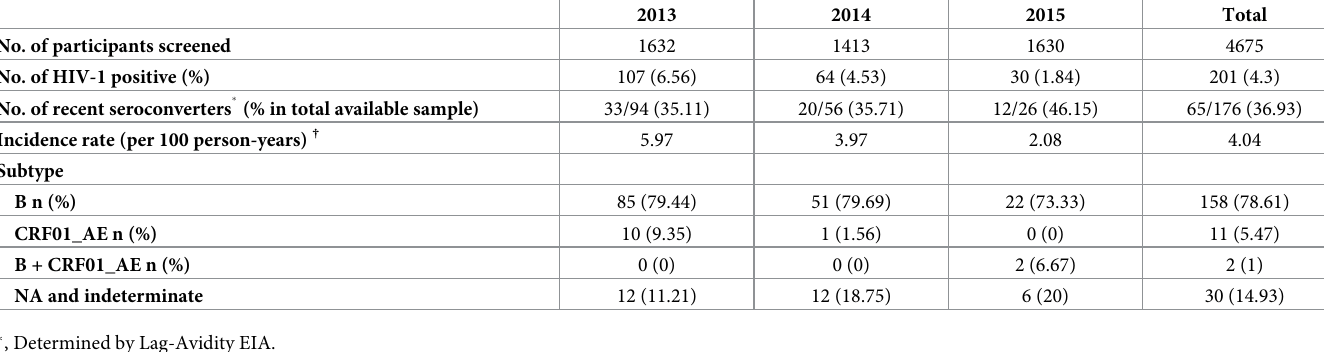
Table 2. Prevalence, incidence rates and subtypes of HIV-1 infection among MSM in 2013–2015 in